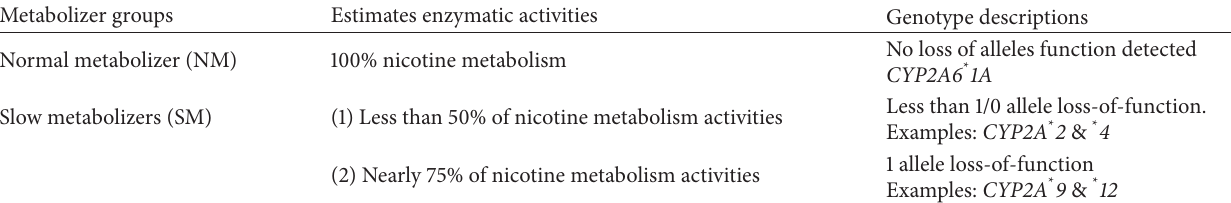
Table 2: Estimates of CYP2A6 gene variants nicotine metabolizer